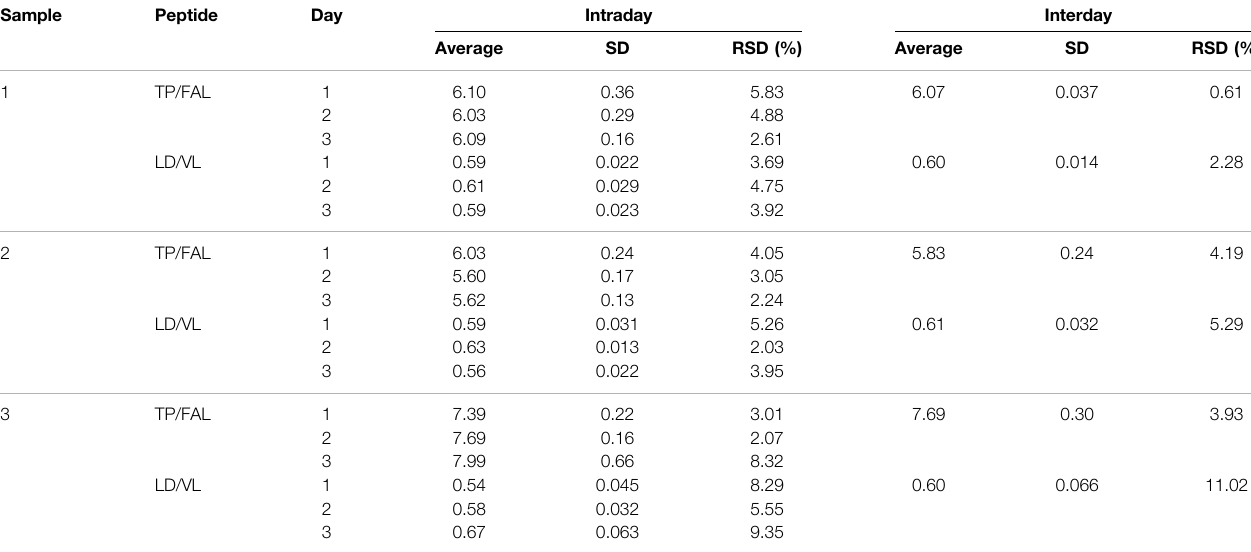
TABLE 5 | Intragroup and intergroup precisions of formula milk powder ( n = 3). Sample